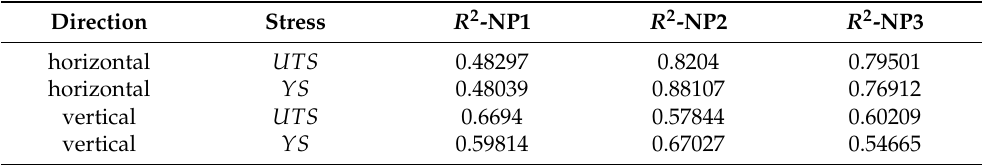
Table 11. Comparison of the correlation coefficient, R 2 , between successive prints, NP1, NP2, and NP3.